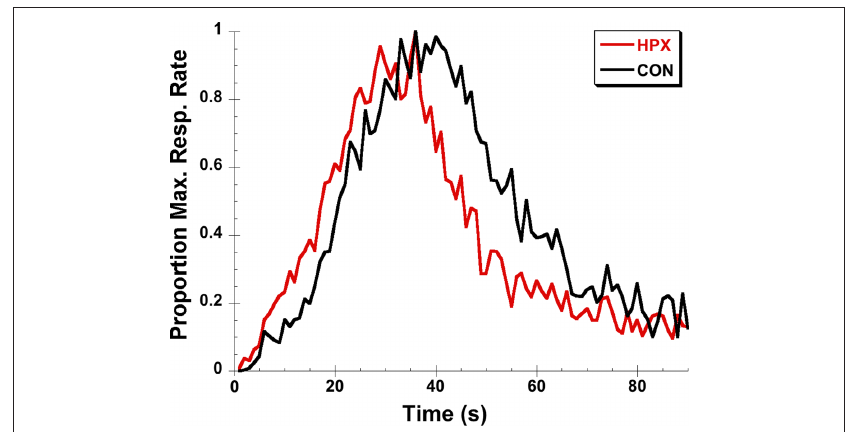
FIgure 1 | An illustration of the “classic” effects of post-training hippocampal lesions for rats trained on a 40-s peak-interval procedure. The peak functions of rats with hippocampal lesions (HPX) rats are shifted leftward relative to control (CON) rats and are sharper with less spread around the observed peak time. Data are replotted from Buhusi et